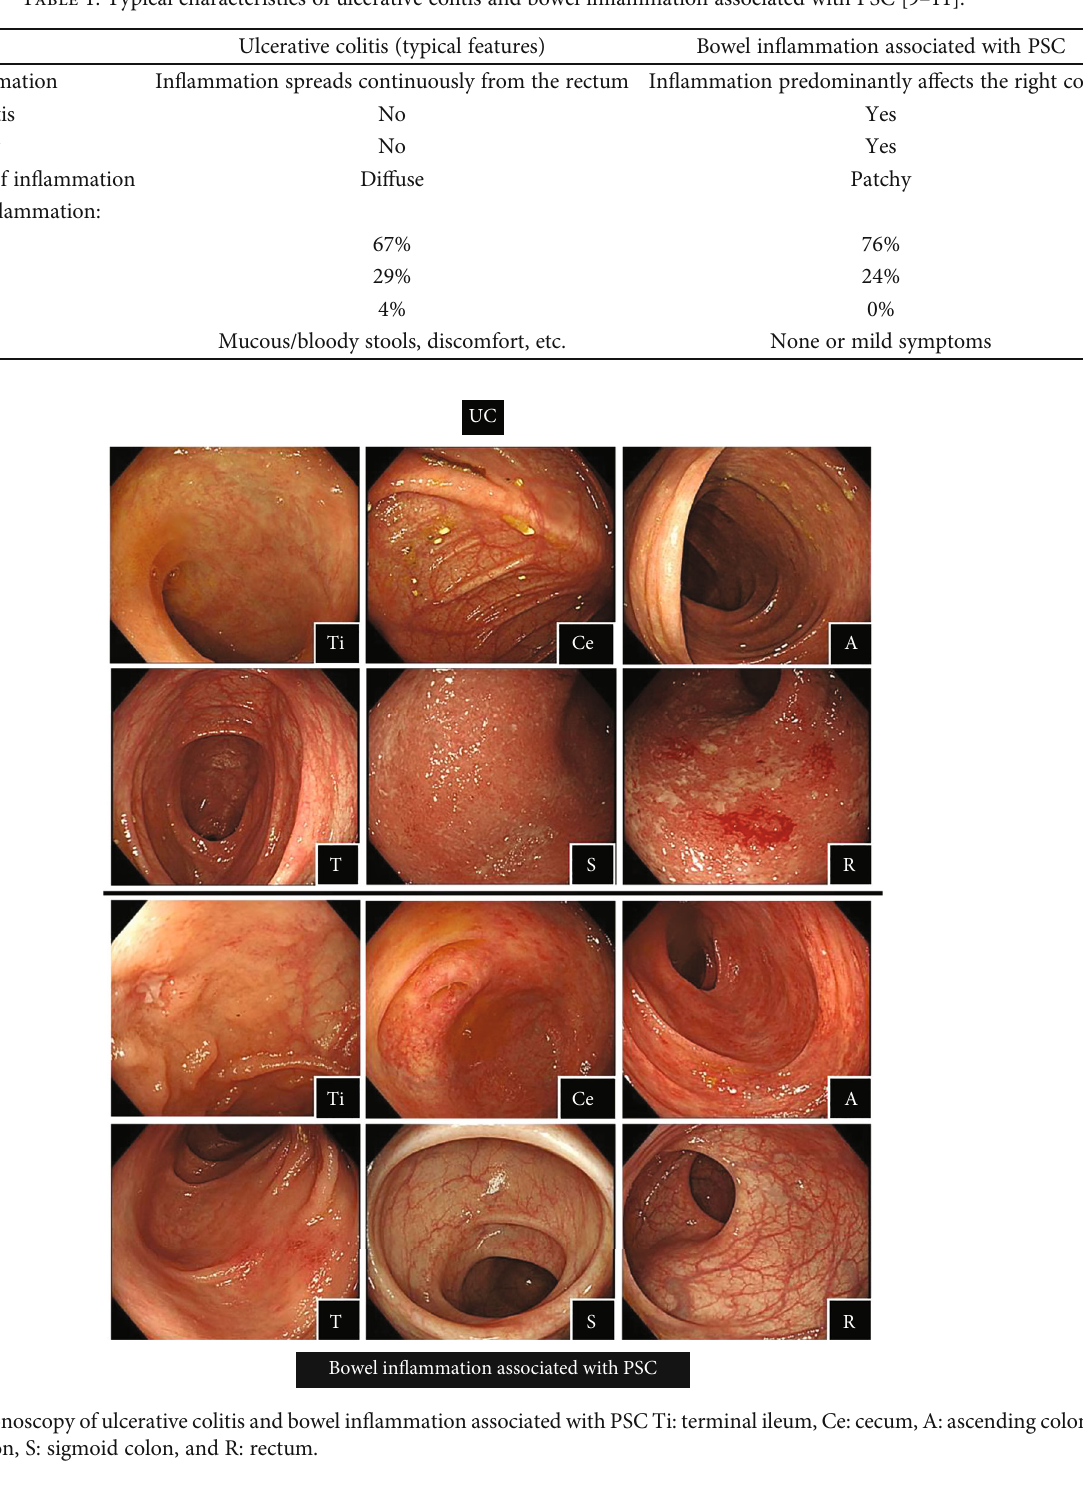
Table 1: Typical characteristics of ulcerative colitis and bowel in fl ammation associated with PSC [9 – 11].